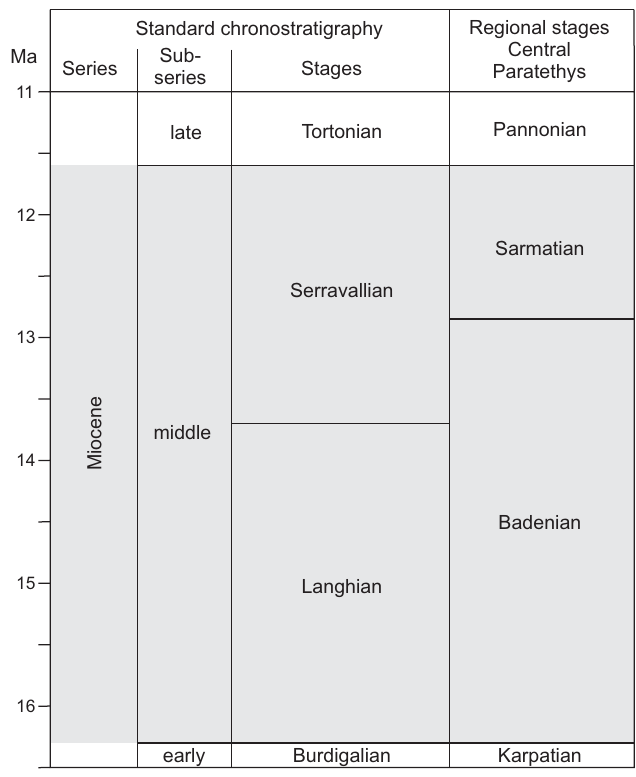
Fig. 2. Stratigraphical chart with standard chronostratigraphy and regional stages for central Paratethys. Grey area covers the time interval in which studied sites are included.